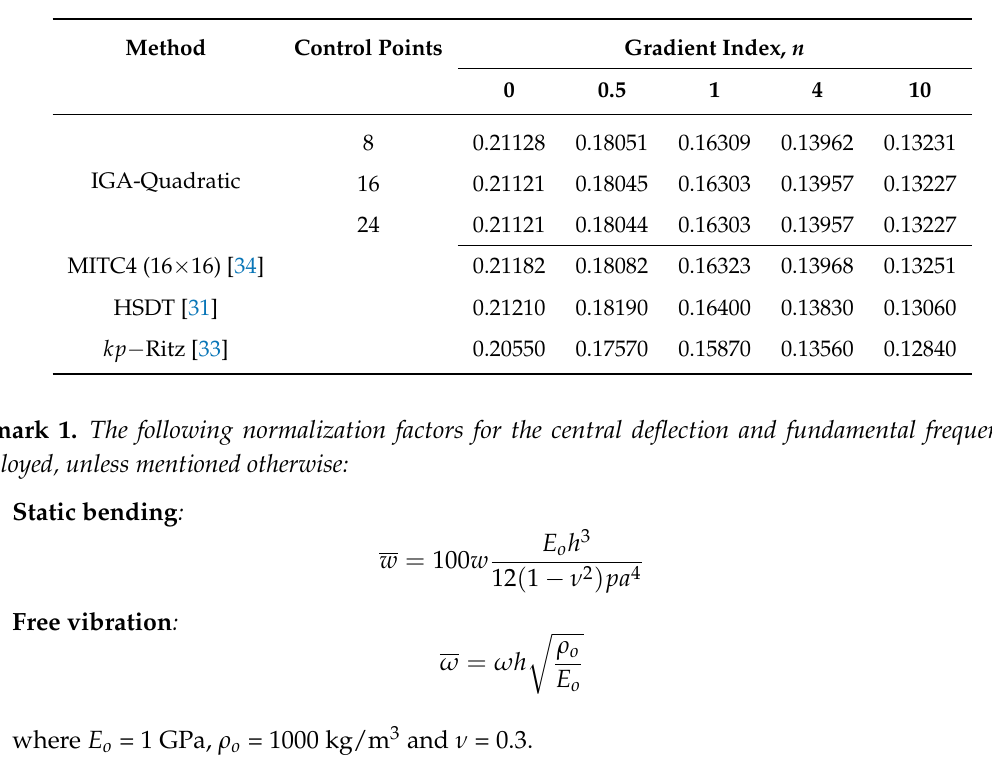
ρ c ω h for a Al/Al 2 O 3 FGM square E c (cid:113) (cid:16) (cid:17)